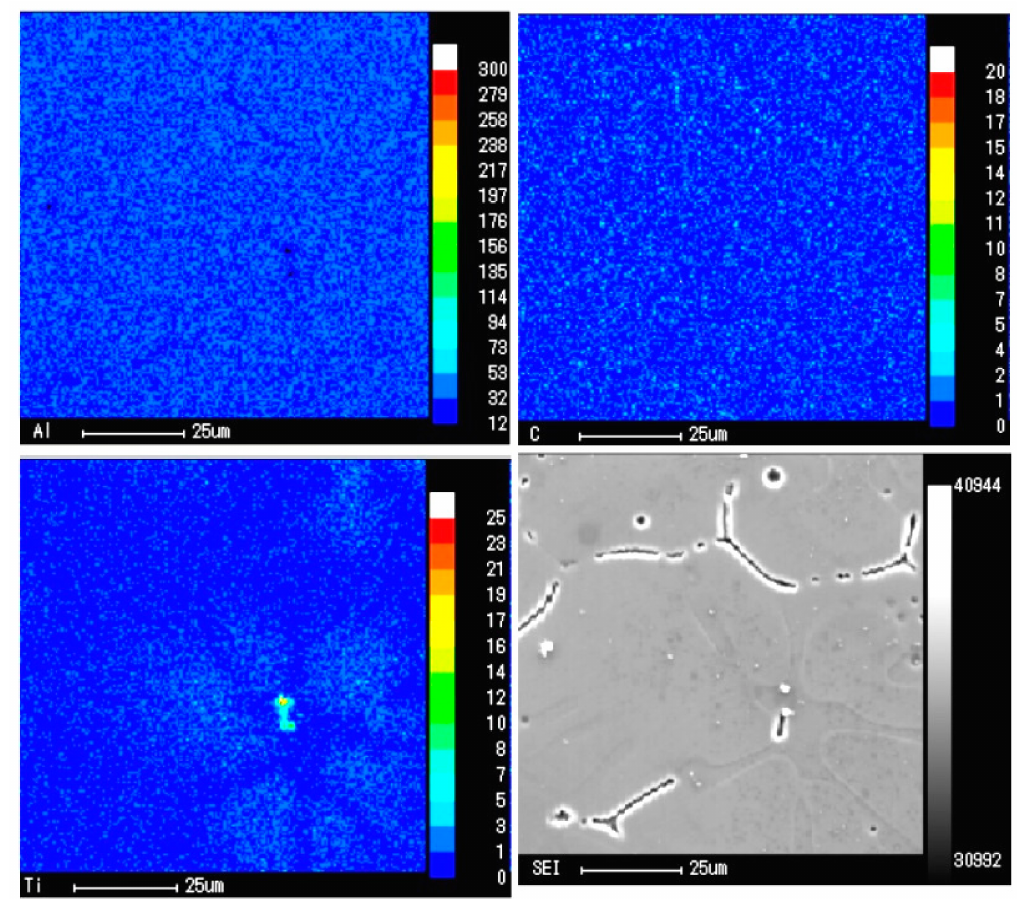
Figure 6. EPMA mapping analysis of A99.7 with the Al-5Ti-0.62C master